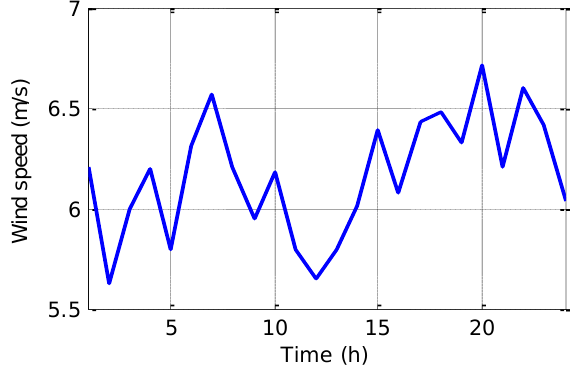
Figure 5. Single-line diagram of the studied 33-bus system.